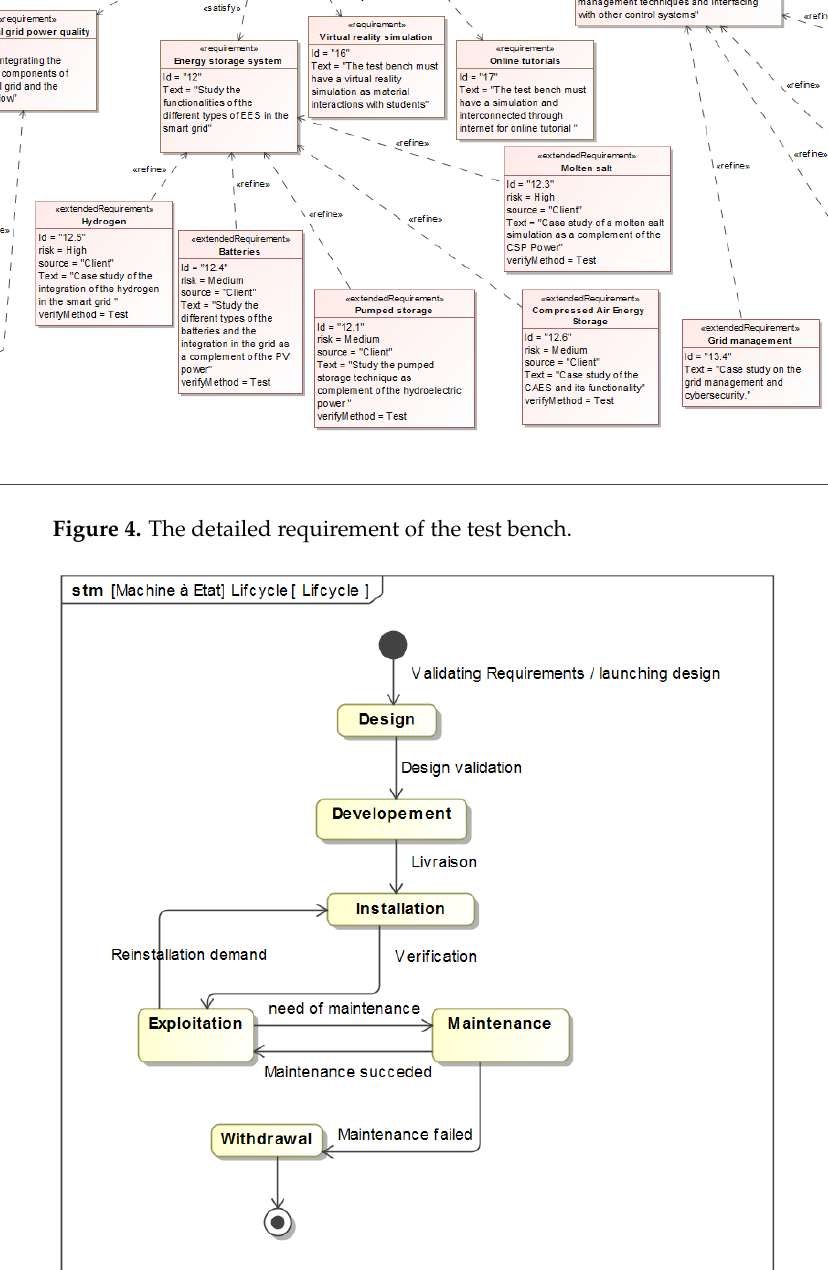
Figure 5. The lifecycle diagram.